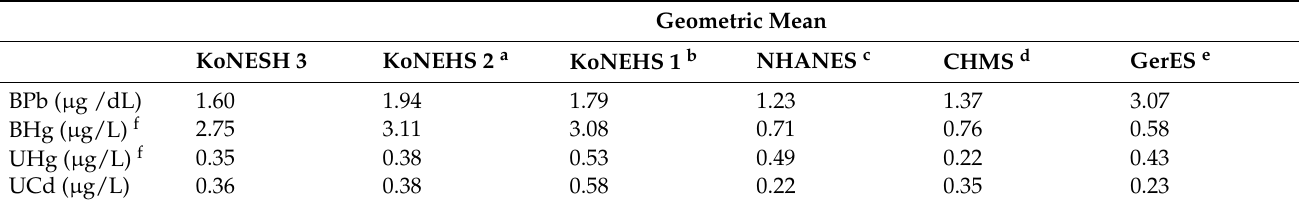
Table 4. Comparison of heavy metal concentrations among the general population. Geometric